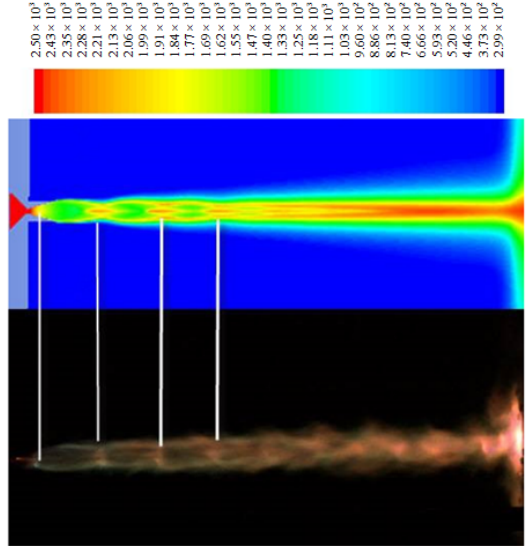
Figure 6. Free jet without water injection.